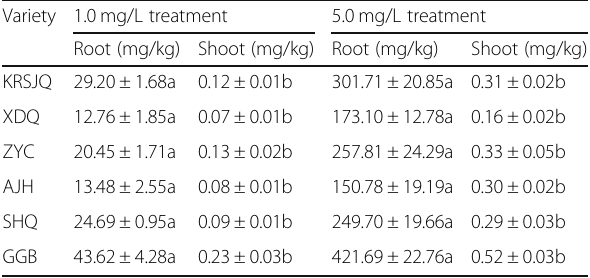
Table 2 DBP concentrations in nutrient solution and vegetable tissues (Kangresijiqing (KRSJQ), Xiadiqing (XDQ), Ziyoucai (ZYC), Aijiaohuang (AJH), Shanghaiqing (SHQ) and Gaogengbai (GGB)) after 24-h exposure. Each treatment consisted of five replicates. The values with the different letter(s) were significantly different ( p <